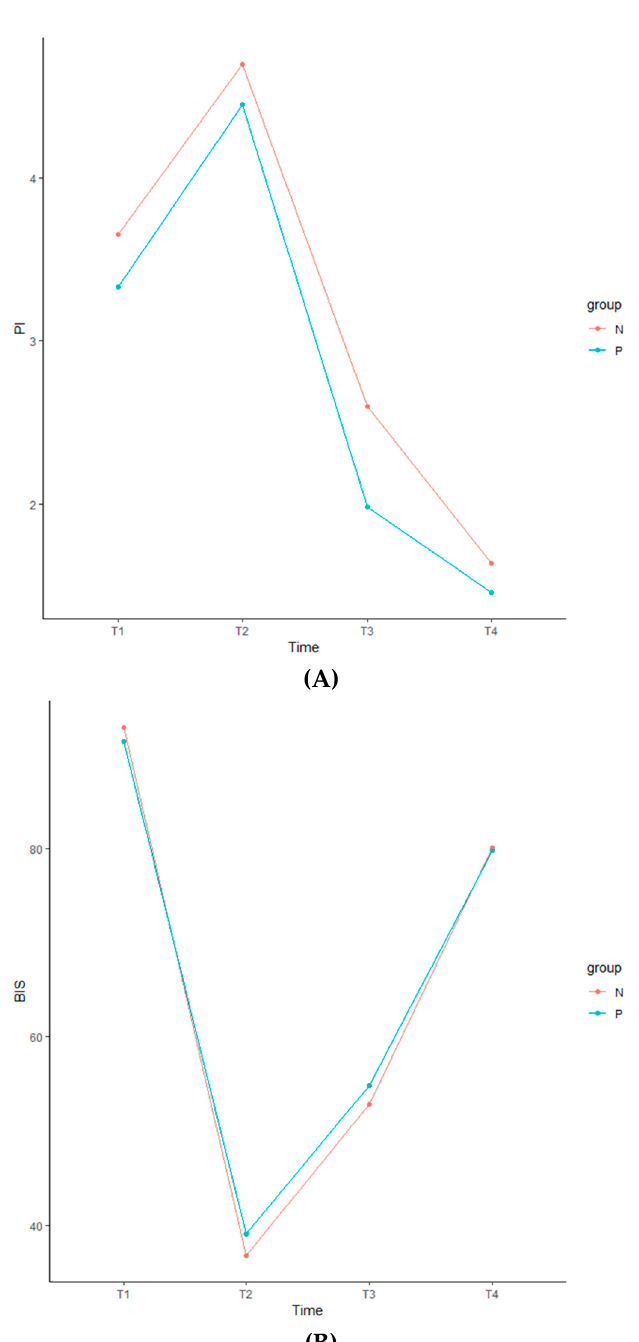
Figure 1. Perfusion index ( A ) and bispectral index ( B ) during anesthesia. We extracted values prior to anesthesia (T1), at surgical incision (T2), at the end of surgery (T3), and after extubation (T4). N: patients with pain scores < 7 in the PACU, Group P: patients with pain scores ≥ 7 in the PACU. PI: Group N: patients with pain scores <7 in the PACU, Group P: patients with pain scores ≥ 7 in the perfusion index, BIS: bispectral index, PACU: postoperative anesthesia care PACU. PI: perfusion index, BIS: bispectral index, PACU: postoperative anesthesia care unit.